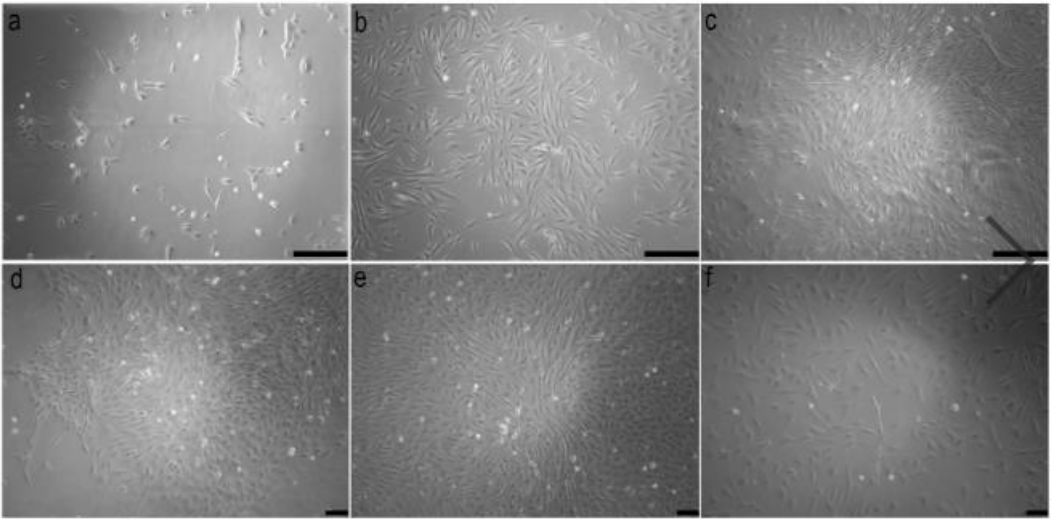
Figure 1. Morphology of attached cell from enzymatic digestion of the muscle tissues of Astyanax Figure altiparanae after three days ( a ). These cells showed more than 80% of cell confluence after 10 days ( b ) and when subcultured, the cell confluence was between two and three days. Note the cells at third passage after three days ( c ). In ( d ), a colony of fibroblastic cells is shown in the fourth passage six days after thawing. These cells show cell confluence after 18 days ( e ) and when subcultured, these cells cover the bottom of the flask in four days. Cell after thawing in the sixth passage after two days of being subcultured. Scale bars 200 µm in ( a – c ); 100 µm in ( d – f ) (10x).